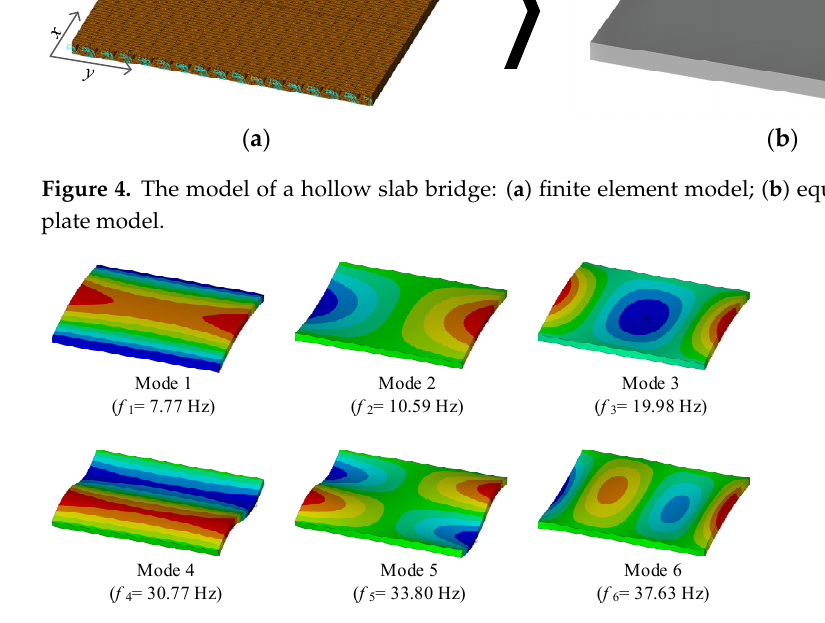
Figure 5. First six modes of the equivalent model.